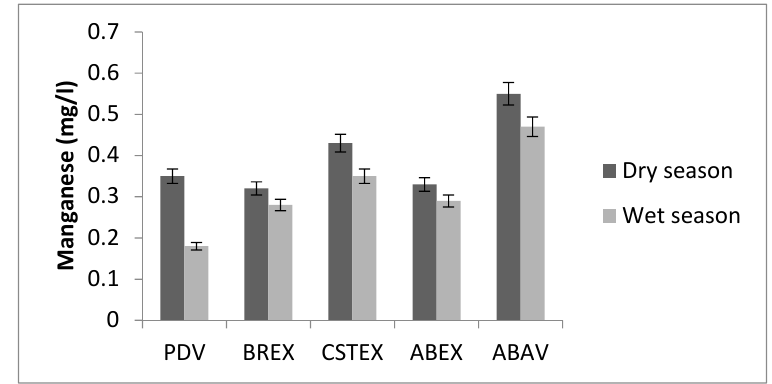
Figure 7. Manganese concentration.